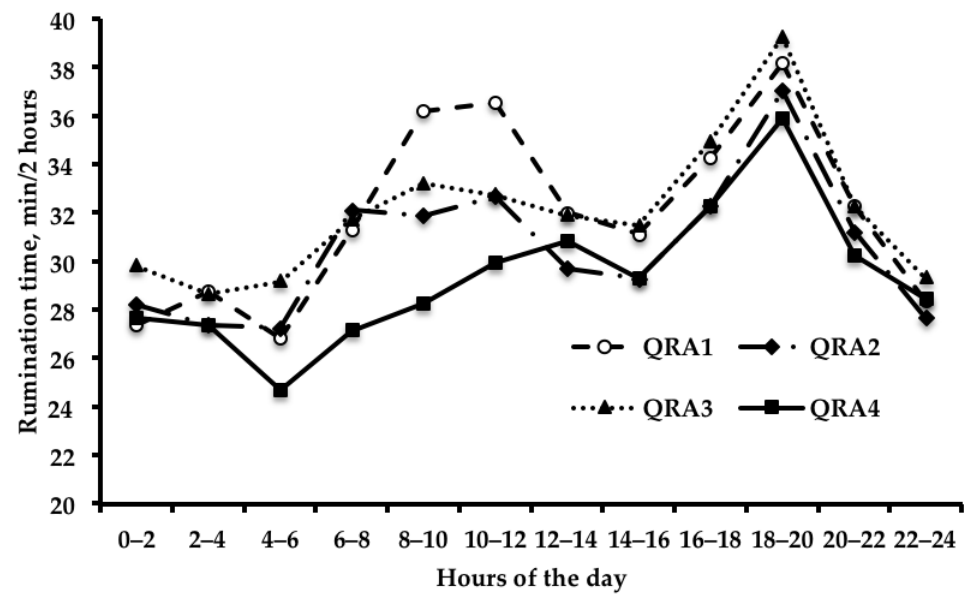
Figure 1. Effect of the quartile of rumen acidity score (QRA1, greatest rumen acidity, to QRA4, lowest rumen acidity) on the time spent in rumination (min/2 h) during the day by lactating Holstein cows ( p value of contrast relative to linear effect of QRA: * < 0.05; SEM ranged from 1.81 to 1.85 min/2 h).